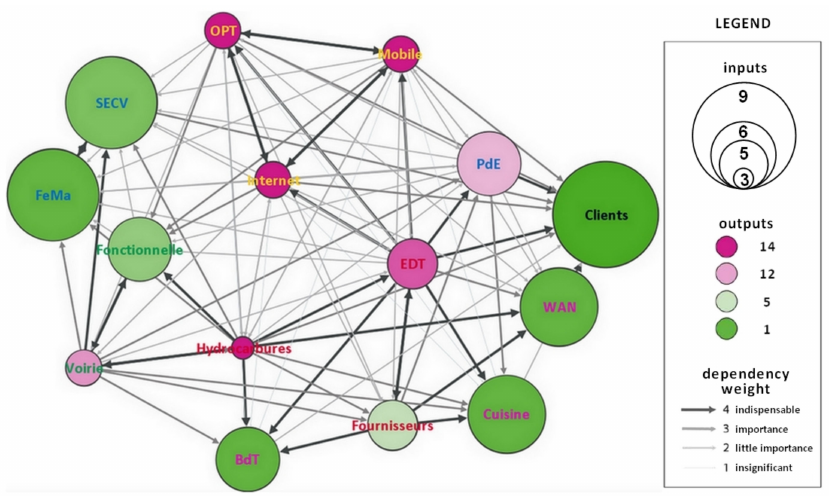
Figure 5. Representation of the interdependencies of the urban technical services of the Punaruu Valley according to the force-atlas spatialization obtained from the Gephi